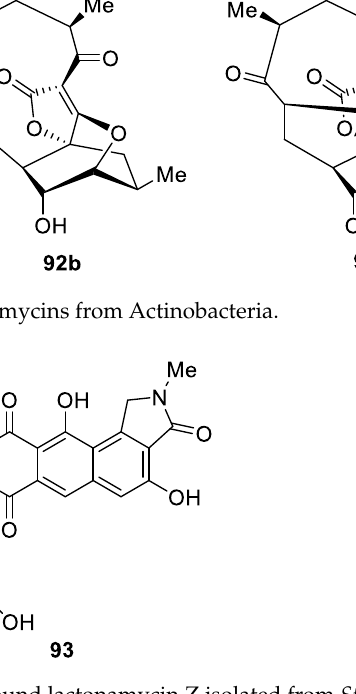
Figure 41. Spirocyclic lactones isolated from endophyte fungal parasites.